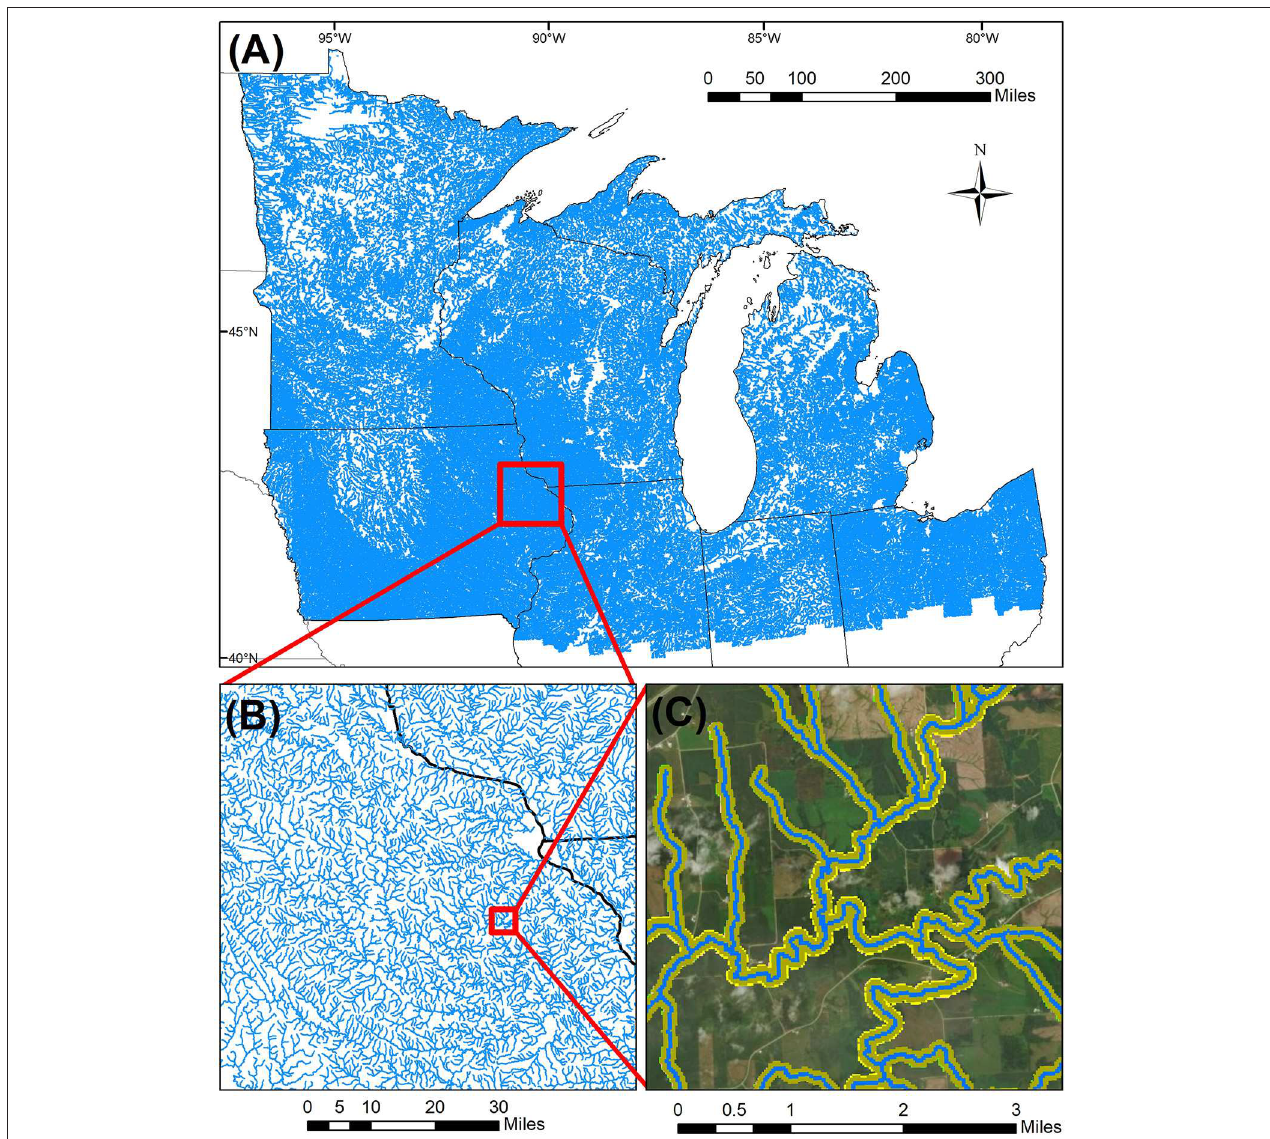
FIGURE 1 | Study area consisting of Minnesota, Iowa, Wisconsin and Michigan along with the northern regions of Illinois, Indiana and Ohio with a National Hydrography Dataset (NHDPlusV2) overlay (A) . Eastern Iowa (B) zoomed in for visualization of NHD flowline complexity. Satellite image (C) with the three continuous riparian buffer scenarios overlaid (Blue: 30-m, Yellow: Variable-Width, Green: